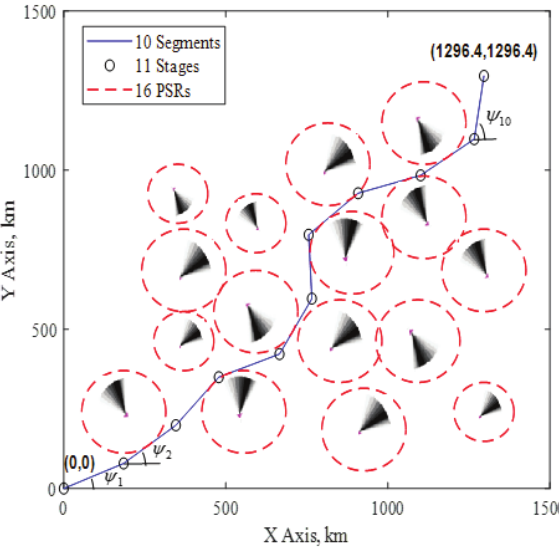
Figure 5. Geometric model without regard for fl ight mechanics